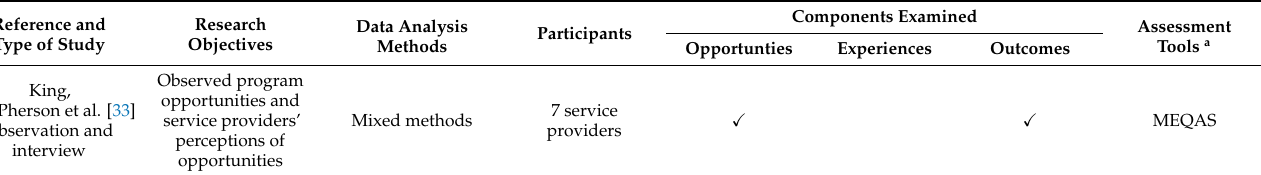
Table 1. Overview of Studies Examining Components of RILS